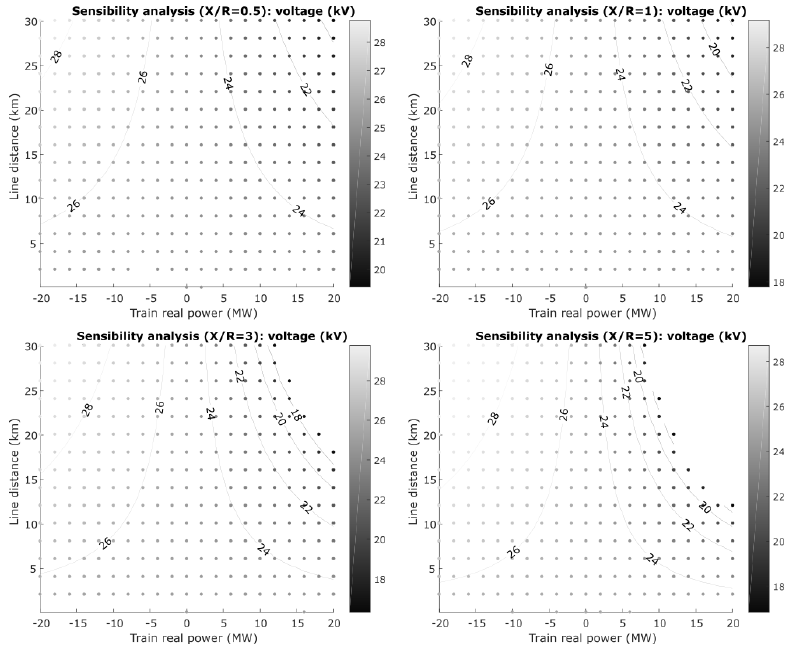
Figure 6. Sensibility analysis for PF T = 0.95 : voltage levels for different X / R L